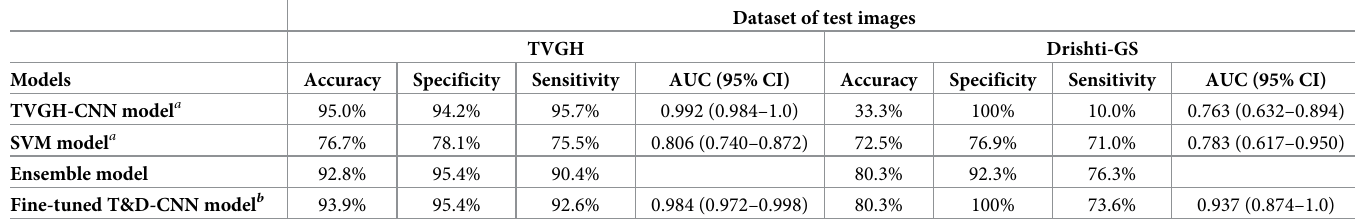
Table 2. Diagnostic capability of the CNN model, SVM model, ensemble model and fine-tuned CNN model in identifying glaucomatous